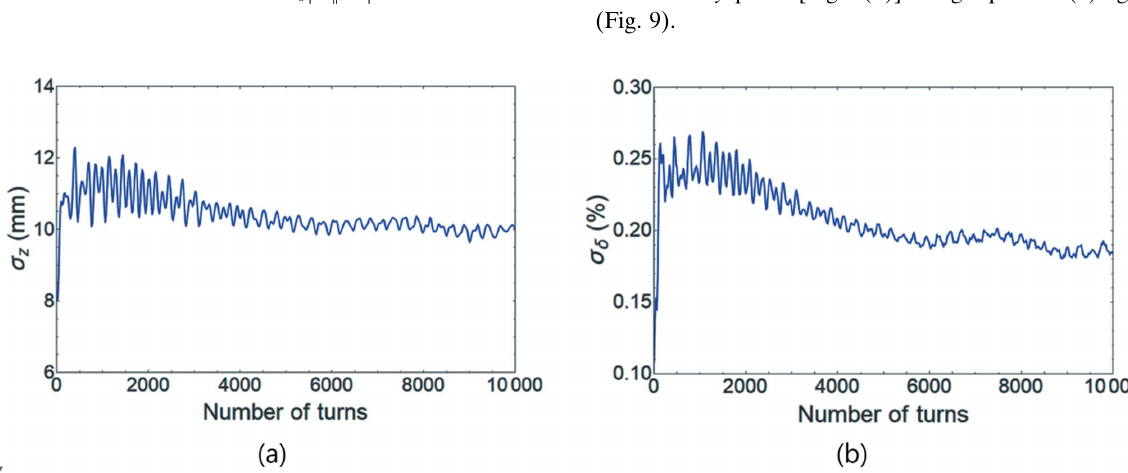
Figure 7 Oscillation of ( a ) r.m.s. bunch length and ( b ) r.m.s. energy spread versus turns when impedance data are included.